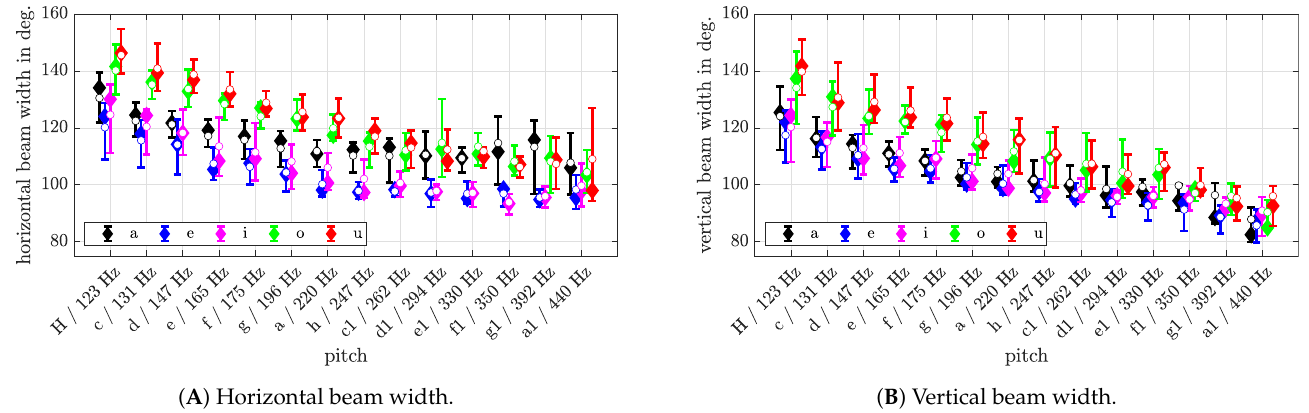
Figure 10. Means (diamonds), medians (dots), IQRs (whiskers) of the horizontal and vertical beam width in degree over pitch for the male singers for the five vowels and all phonation